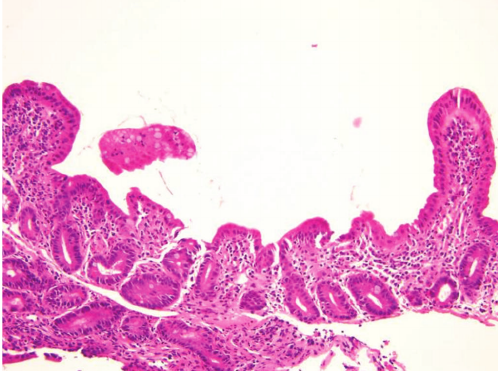
Figure 3: Biopsy of duodenum showing patchy villous blunting, increased intraepithelial lymphocytes, gastric mucin cell (foveolar) metaplasia, and reactive glandular changes within the crypts. No evidence of vasculitis or granuloma (Hematoxylin and Eosin 20 ×